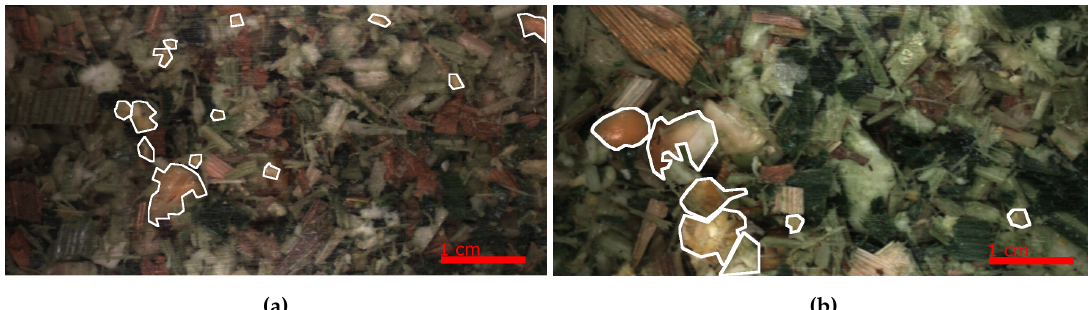
Figure 3. Example images of the differences in silage harvested with varying fragmentation. The white outline shows kernel fragment annotation outlines. ( a ) Smaller Processor Gap (PG) resulting in smaller kernel fragments; ( b ) Larger PG resulting in larger kernel fragments. A scale in the bottom right of the images shows the size of the images where 200 pixels is equal to 1